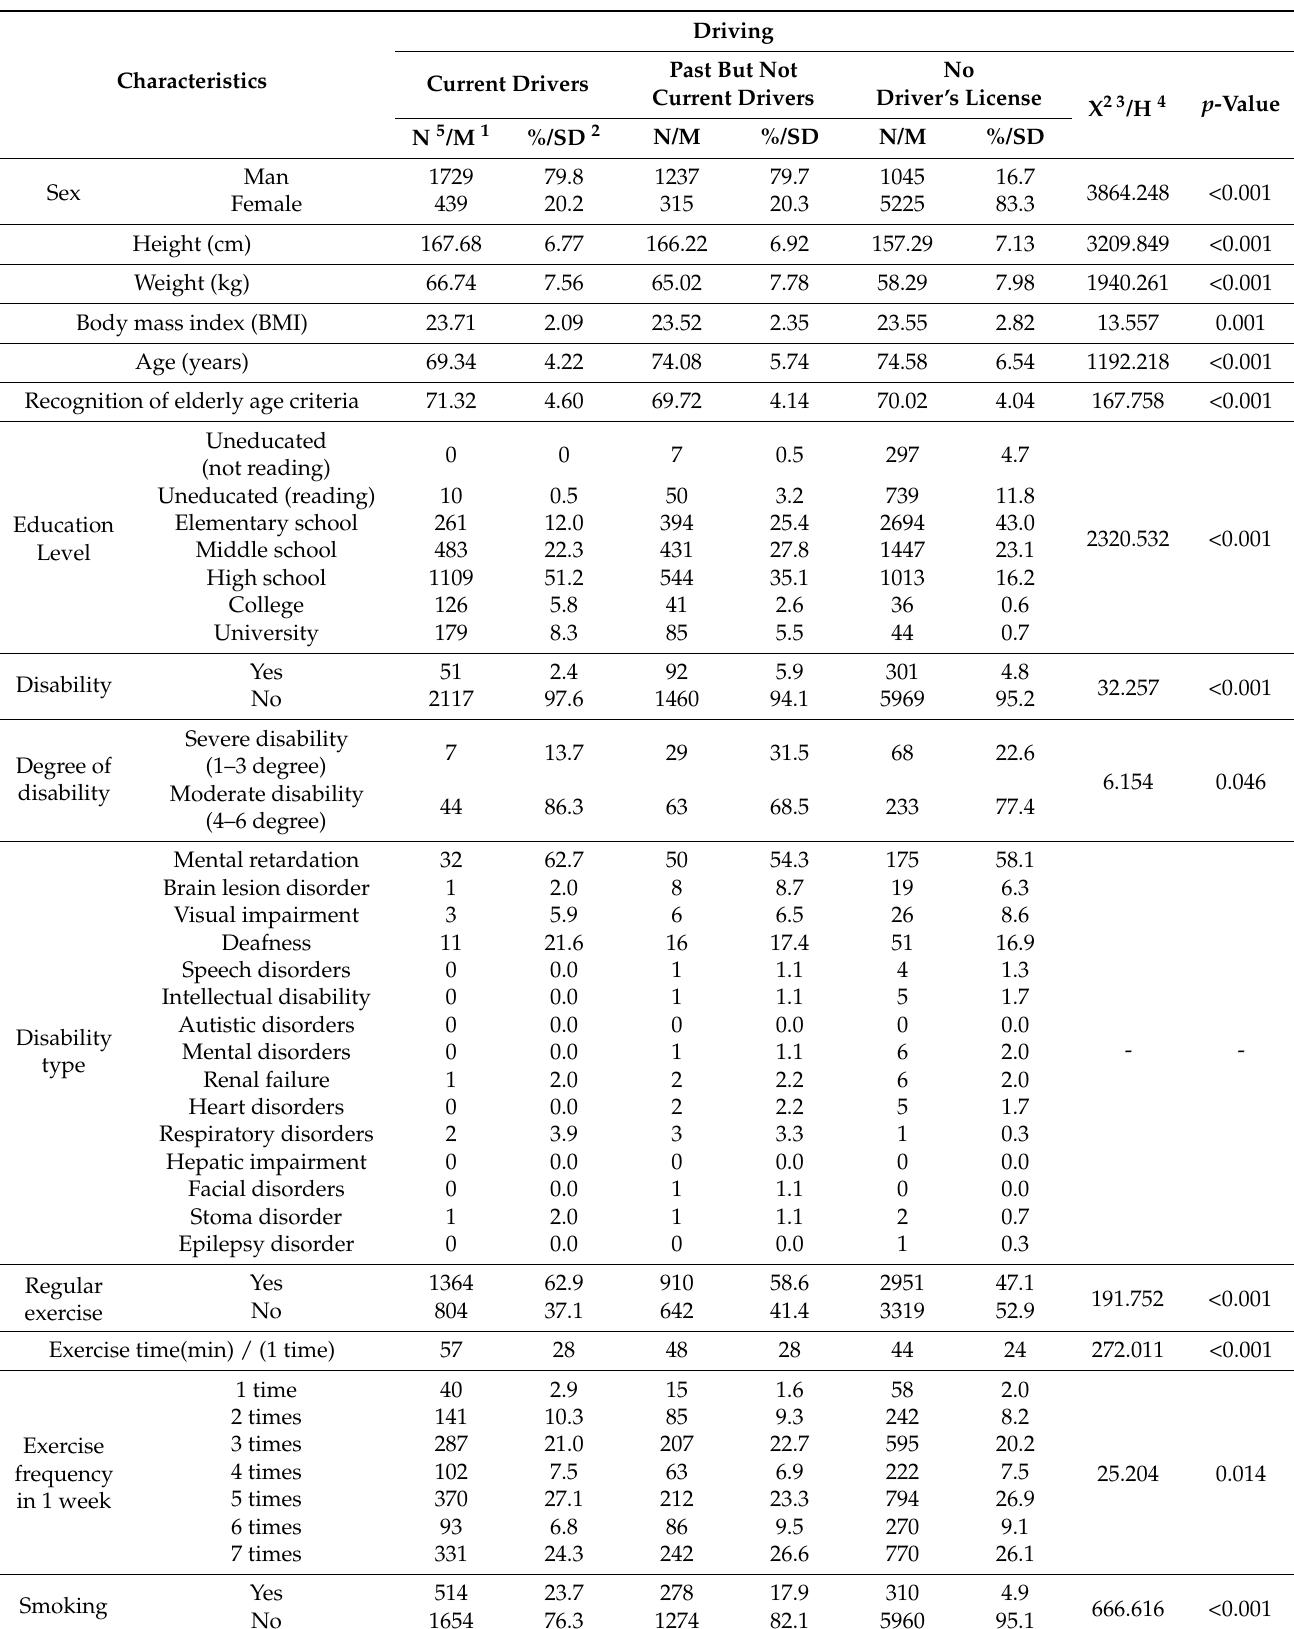
Table 1. General characteristics of the